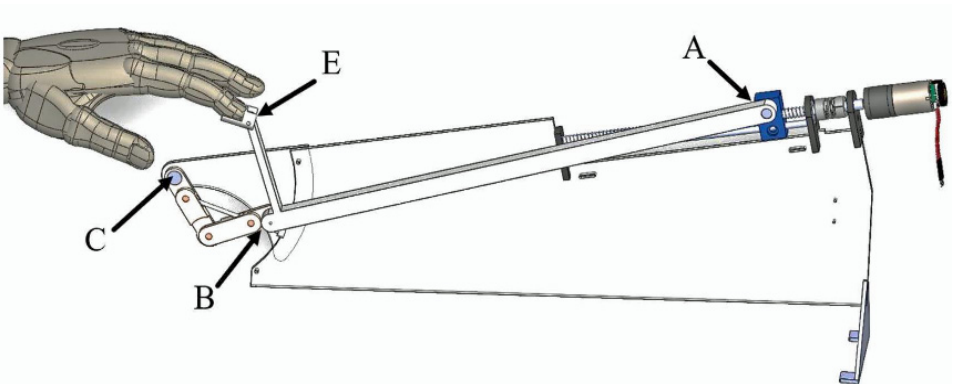
Figure 4. R-RRT mechanism of the index finger.